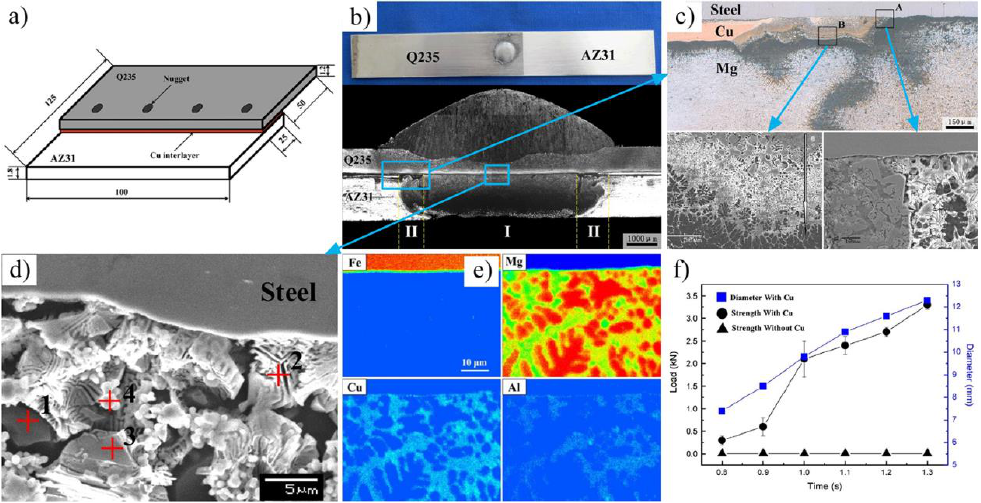
Figure 17. CMT spot welding with Cu interlayer [57] ( a ) schematic of the welding arrangement; ( b ) nugget surface and cross-section photograph; ( c ) microstructures of the interface at the nugget edge; ( d ) microstructures of the interface at the center of the nugget; ( e ) interfacial elemental distribution analysis at the center of the nugget; ( f ) relation between tensile shear strength and welding time.